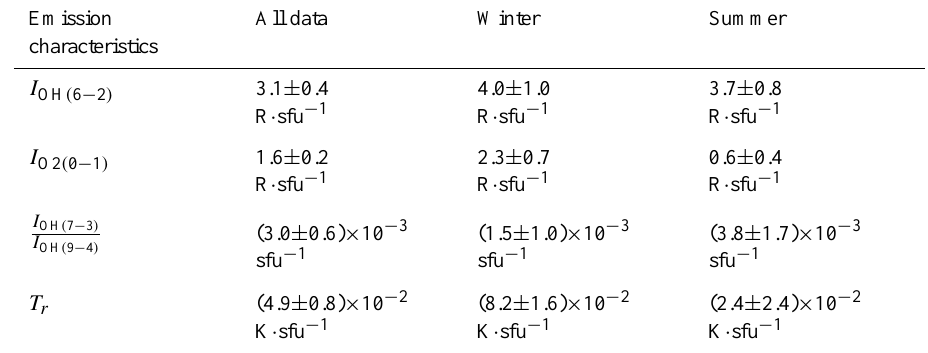
Table 4. Response of the emission characteristics to solar activity as the ratio of their 11-year